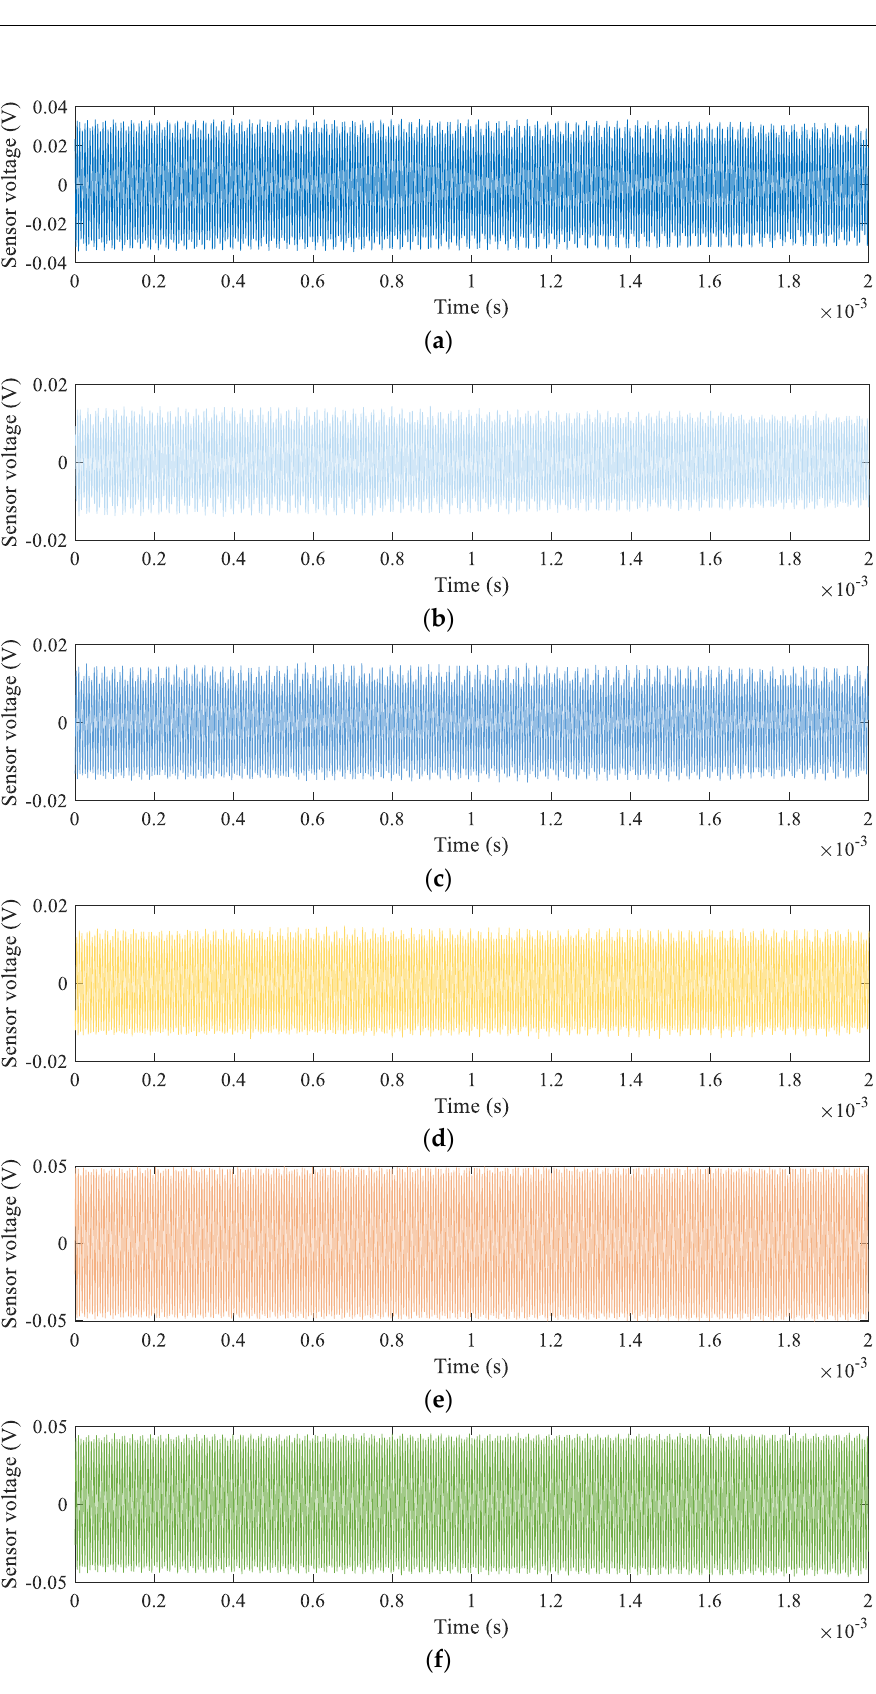
Figure 6. Sensor signal response of each type of timber damage mode. ( a ) Case 1, ( b ) Case 2, ( c ) Case 3, ( d ) Case 4, ( e ) Case 5, ( f ) Case